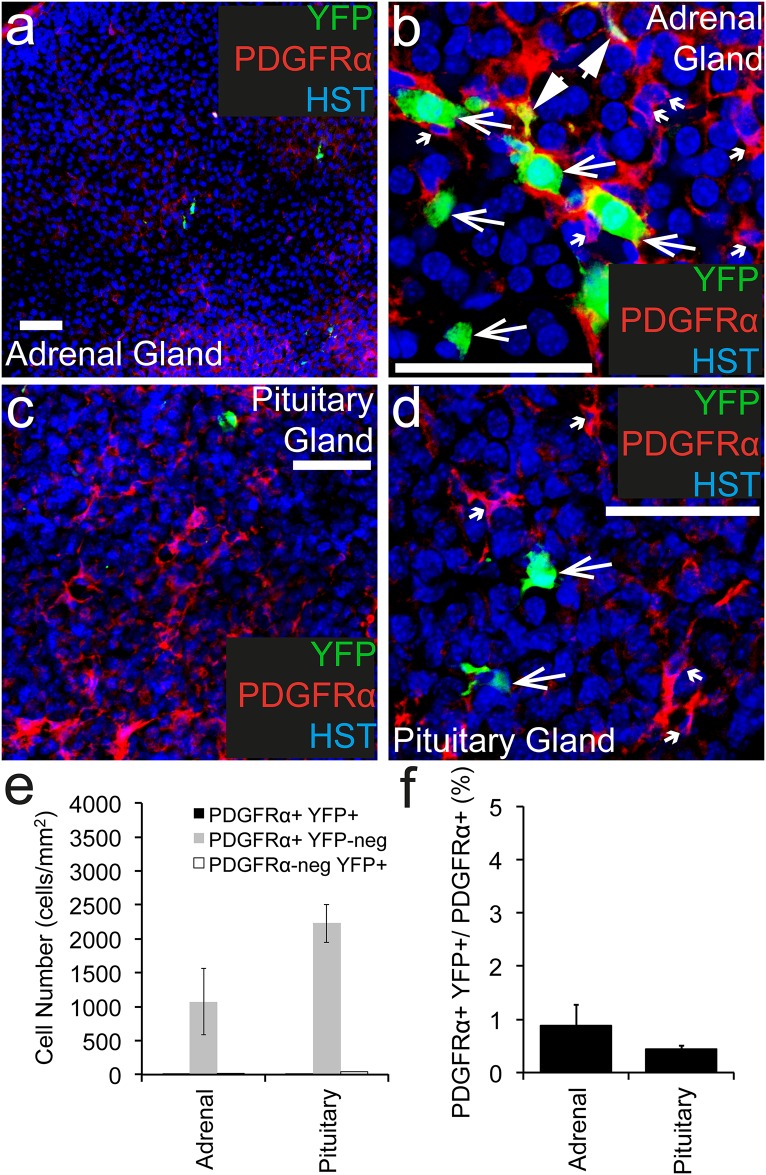
PDGFRα+ cells recombine at low efficiency in endocrine tissue.Cryosections through the adrenal and pituitary gland of P57+7 Pdgfrα-CreERT2::Rosa26-YFP were immunostained to detect PDGFRα (red), YFP (green) and Hoescht 33342 (blue). Confocal image (single z plane) of the adrenal gland at low (a) and high (b) magnification. Confocal image (single z plane) of the pituitary gland at low (c) and high (d) magnification. (e) The number of PDGFRα+ YFP+, PDGFRα+ YFP-negative and PDGFRα-negative YFP+ cells quantified from confocal images (single z plane) of the adrenal and pituitary glands, expressed as the number of cells per mm2. (f) The proportion of PDGFRα+ cells that become YFP-labelled (PDGFRα+ YFP+ cells / total PDGFRα+ cells, x 100) quantified from confocal images (single z plane) of adrenal and pituitary gland. Error bars represent mean ± std dev from n = 3 mice. PDGFRα+ YFP+ cells are denoted by arrowheads. PDGFRα-negative YFP+ cells are denoted by arrows. PDGFRα+ YFP-negative cells are denoted by small arrows. Scale bars represent 50μm.